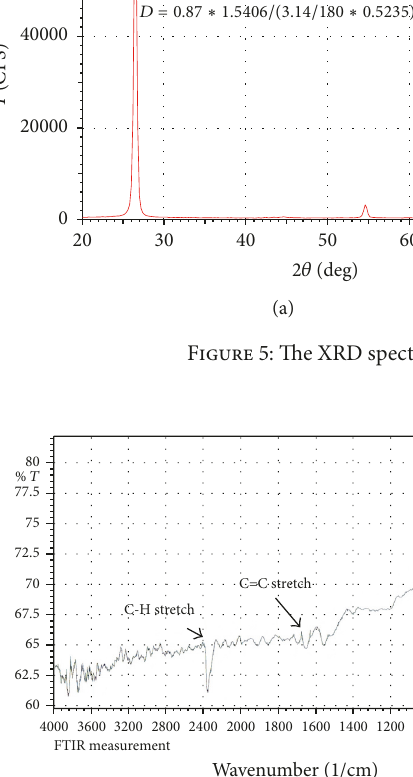
Figure 6: The FTIR transmission spectrum of electroreduced GO produced by Hammers method.